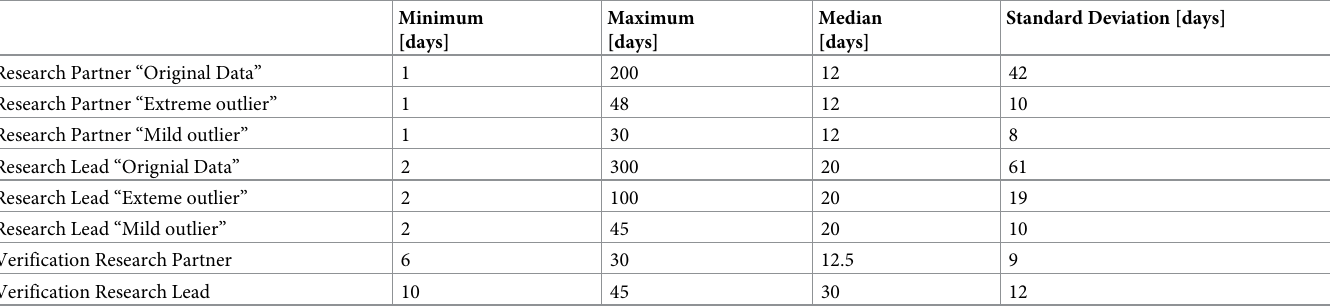
Table 3. Analysis of the remaining data: Minimum, Maximum, Median, Standard Deviation.